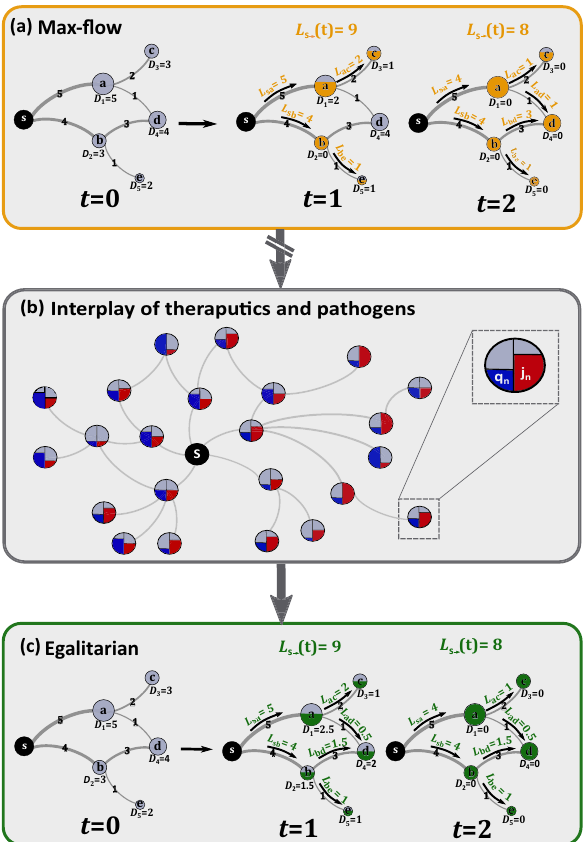
Figure 1. Optmizing therapeutic dissemination for efficient mitigation. We treat the theraputic spread as a commodity flow problem. ( a ) Commodities flow from the source s to fill the demands D n ( t ) at all destinations a through e . The transportation network imposes constraints, expressed by the restricted shipping capacity of all links. For example, the route s → a can transport at most 5 units per day (edge labels). The shipping sequence determines the quotas shipped via each link L nm , and hence the rates by which all nodes are supplied. Demands are updated as therapeutics are supplied—for instance, at t = 1 b ’s demand D 2 ( t ) is updated to zero, as b ’s quota is filled. Under max-flow the goal is to achieve the highest net outflow of commodities from s , i.e. maximize L s → ( t ) . Here, nodes were supplied within 2 days, a net flow L s → ( 1 ) = 9 in day 1 and L s → ( t ) = 8 , in day 2 . ( b ) During an epidemic, however, the goal is to achieve optimal mitigation, not just optimal commodity flow. This requires us to consider the interplay between our dissemination and the spread of the epidemic. Each node’s demand is determined by its infection levels ( j n ( t ) , red), leading us to seek the shipping sequence which best adresses the anticipated spread of infections—aiming for supply ( q n ( t ) , blue) that is most compatible with demand. ( c ) We find that the optimal strategy is to design an egalitarian flow, in which supply is homogeneously spread across all destinations. Using the same network as in ( a ), our egalitarian strategy yields a balanced shipping sequence, in which nodes are supplied concurrently at roughly equal rates. For example, instead of fully supplying node b in t = 1 and only then shipping to d at t = 2 , as done under max-flow in ( a ), our egalitarian algorithm favors the shipping sequence where b and d are simulataneasly supplied at equal rates. Under global demand, we show, such egalitarian supply is orders of magnitude more effective in terms of mitigation and resource